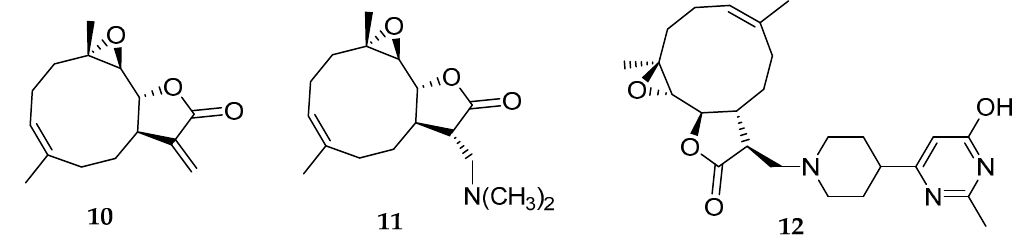
Figure 9. Structure of parthenolide ( 10 ) and its derivatives DMAPT ( 11 ) and HMPPPT ( 12 ).